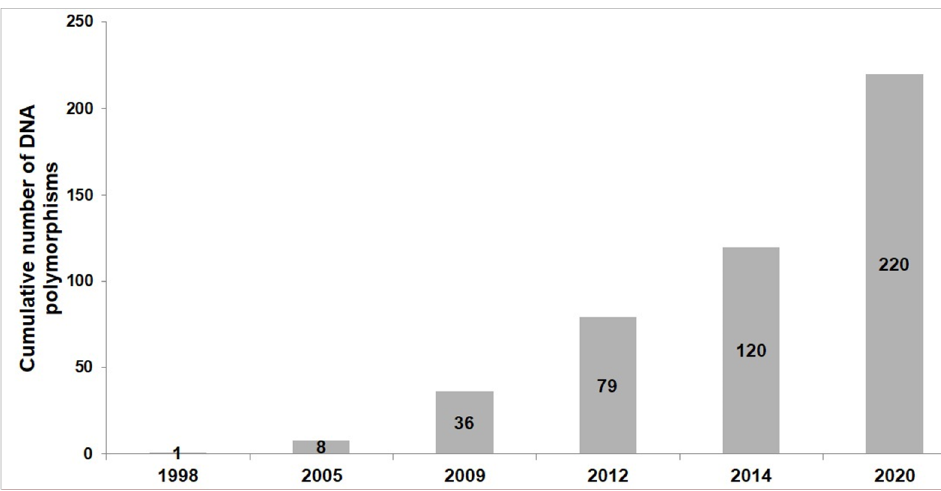
Figure 1. Sports-related DNA polymorphisms discovered between 1998 and 2020.